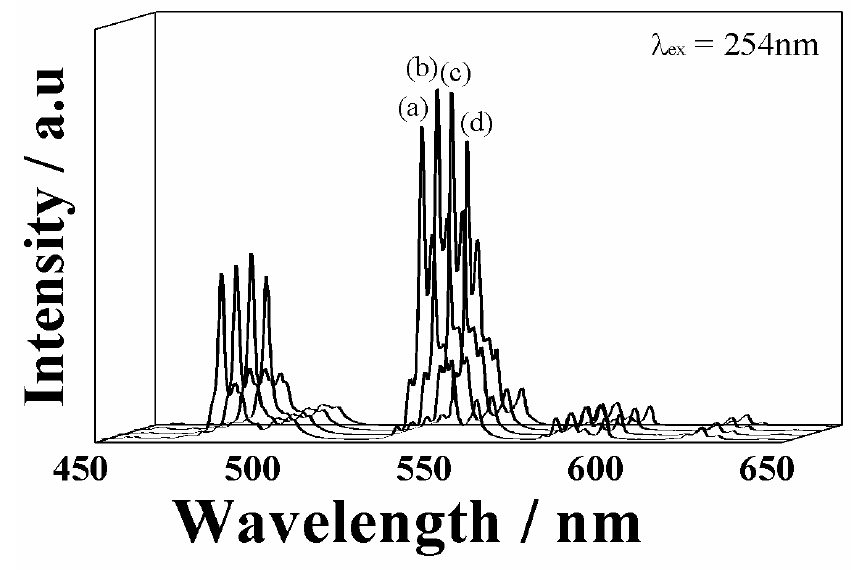
Figure 6. Dependence of the emission intensity on the Gd 3+ concentration in the (La Gd )OBr:5%Tb 3+ (0 ≤ x ≤ 0.15) phosphors. The excitation wavelength is 254 nm for both x x (La Gd )OBr:5%Tb 3+ and LaPO 1- x x